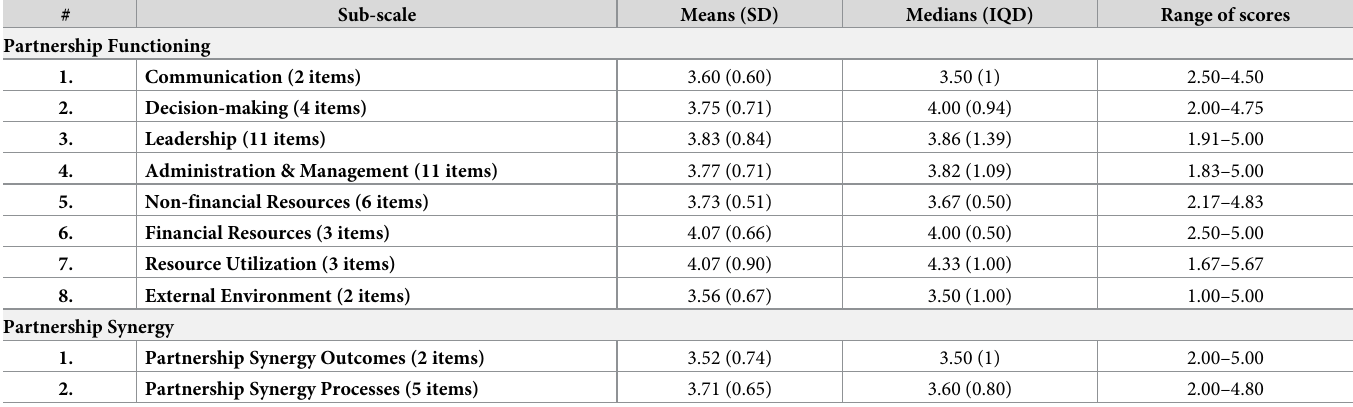
Table 3. Score distribution for the partnership functioning and partnership synergy sub-scales ( N = 54). Responses to various five-point Likert scales response options have a negative (1) to positive (5)